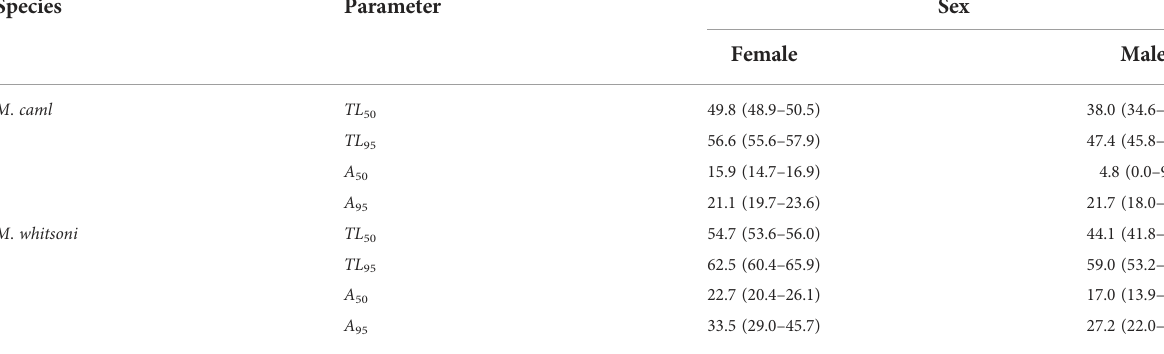
TABLE 6 Total lengths (TL, cm) and ages (A) by which 50% and 95% ( TL 50 , TL 95 , A 50 , A 95 ) of female and male Macrourus caml and M . whitsoni in the Ross Sea region have attained sexual maturity. Species